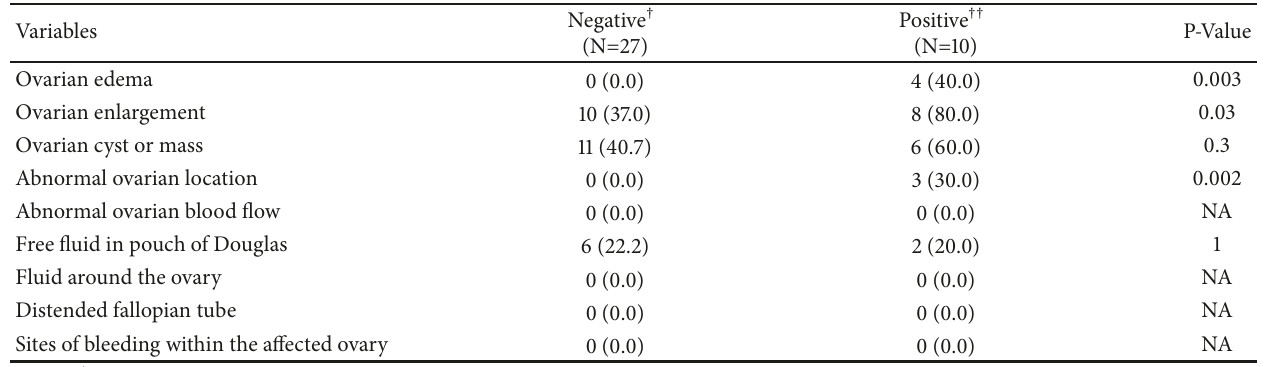
Table 3: Presence of the various sonographic markers in the torsion and no torsion